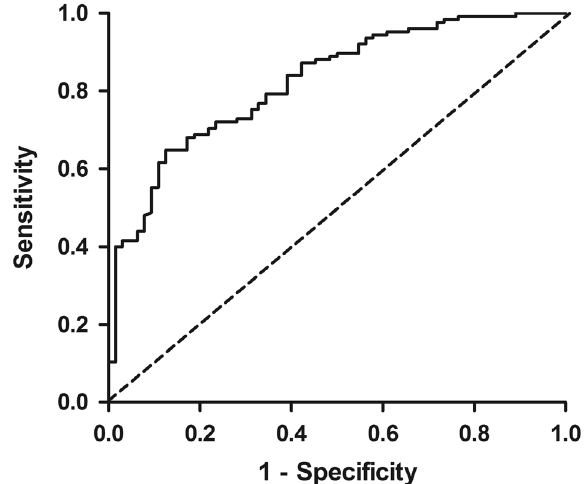
Fig. 2 ROC of PEF for detection of